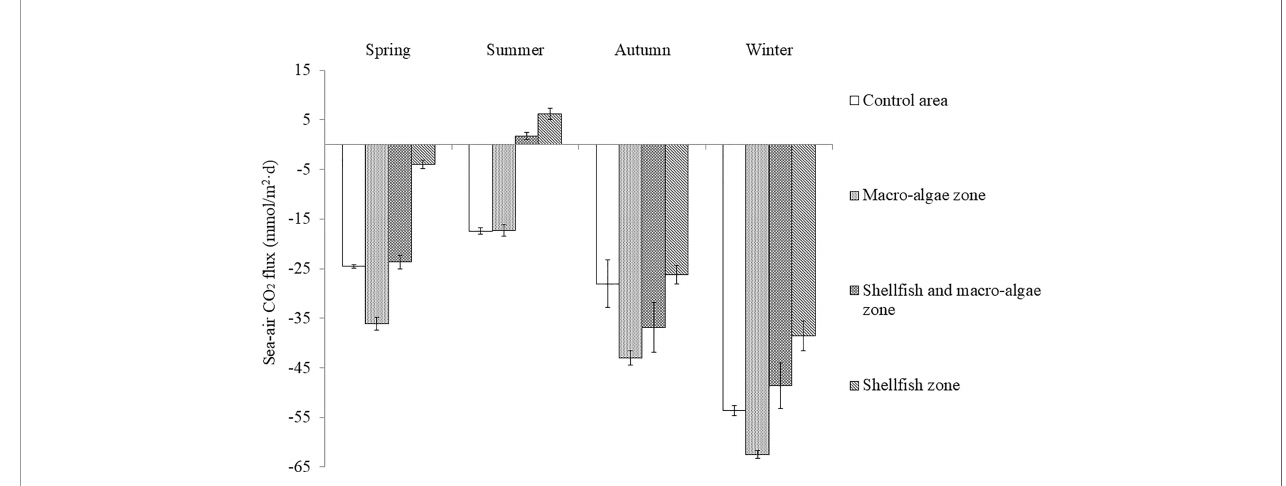
FIGURE 6 | Seasonal variation in sea – air CO 2 fl ux in Sanggou Bay.